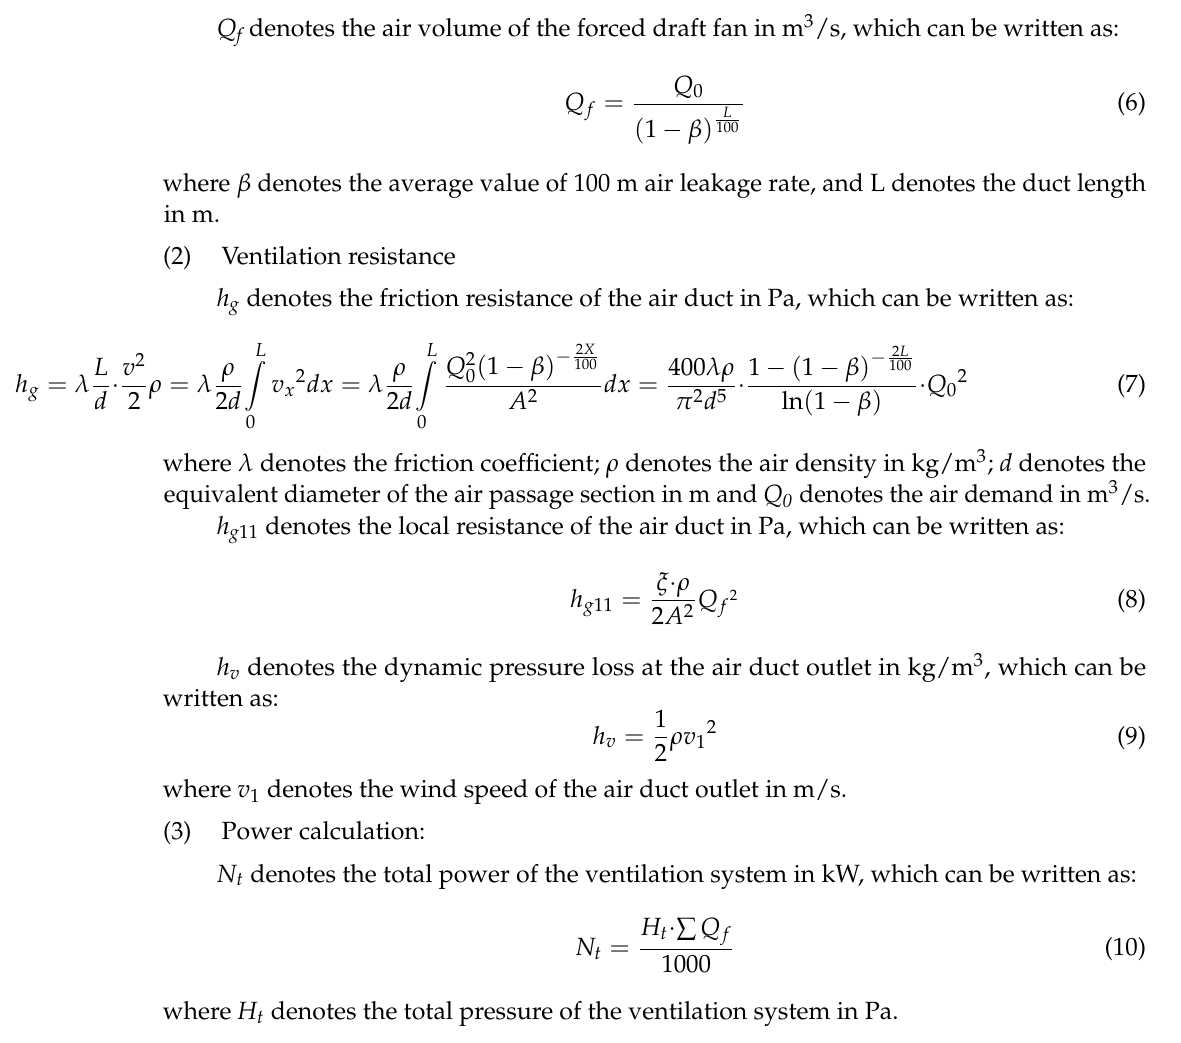
Table 3. Energy consumption of a blowing ventilation system.